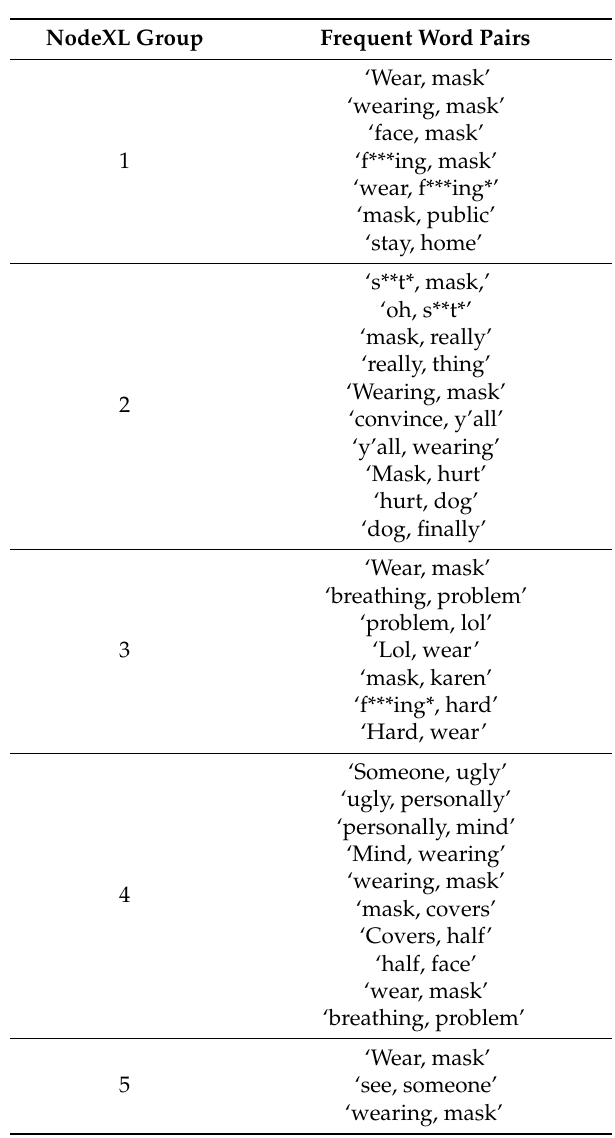
Table 4. Identifying content across